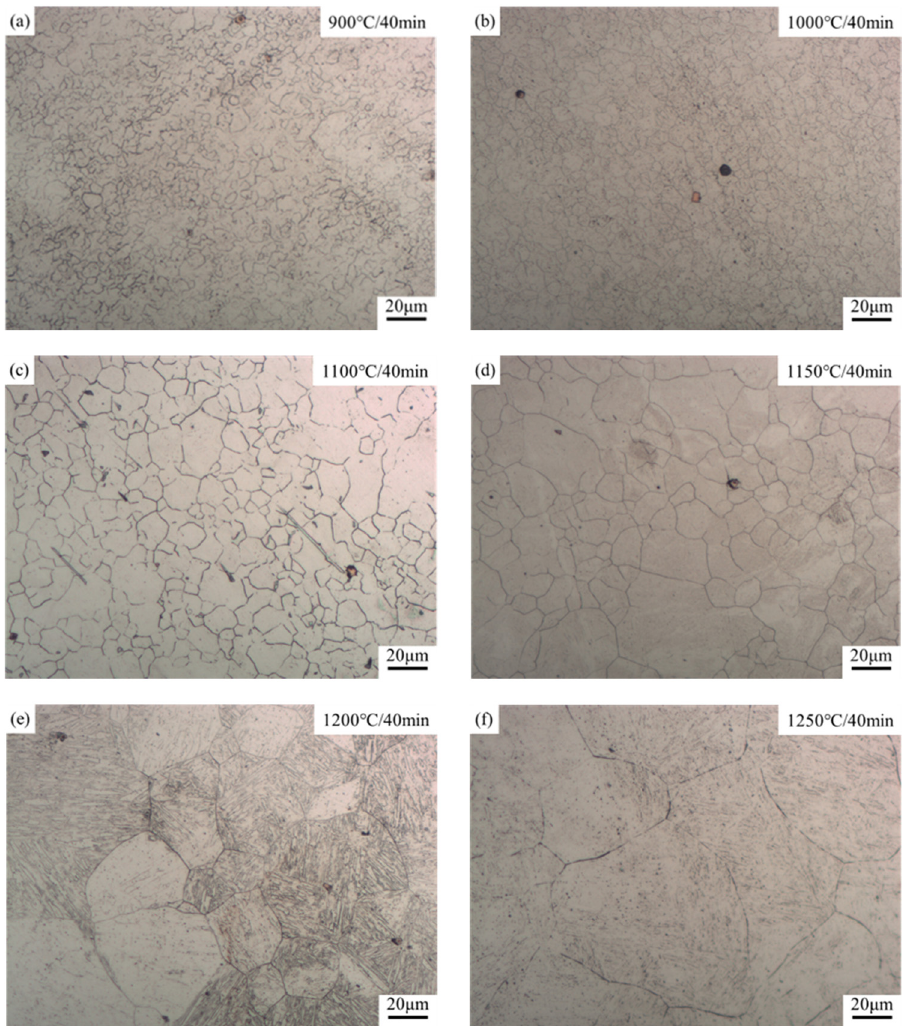
Figure 5: The austenite grain morphology after holding for 40 min at di ff erent quenching temperatures: ( a ) 900°C, ( b ) 1,000°C, ( c ) 1,100°C, ( d ) 1,150°C, ( e ) 1,200°C, and ( f )